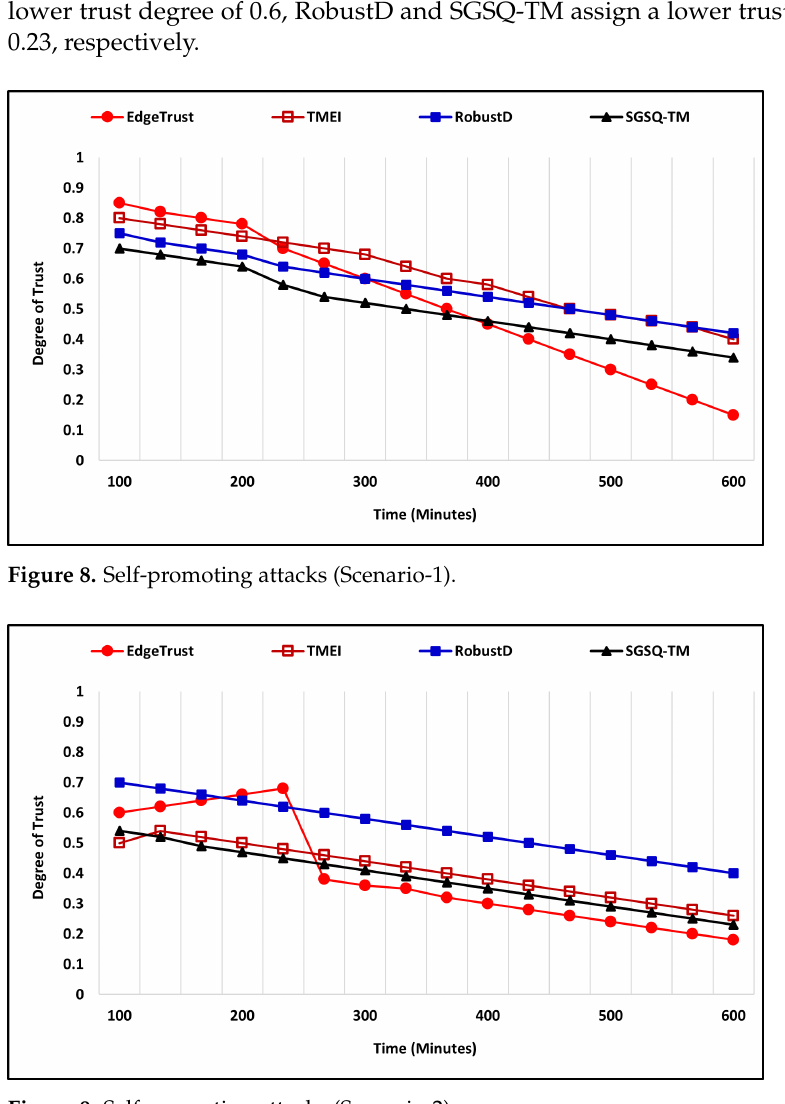
Figure 9. Self-promoting attacks